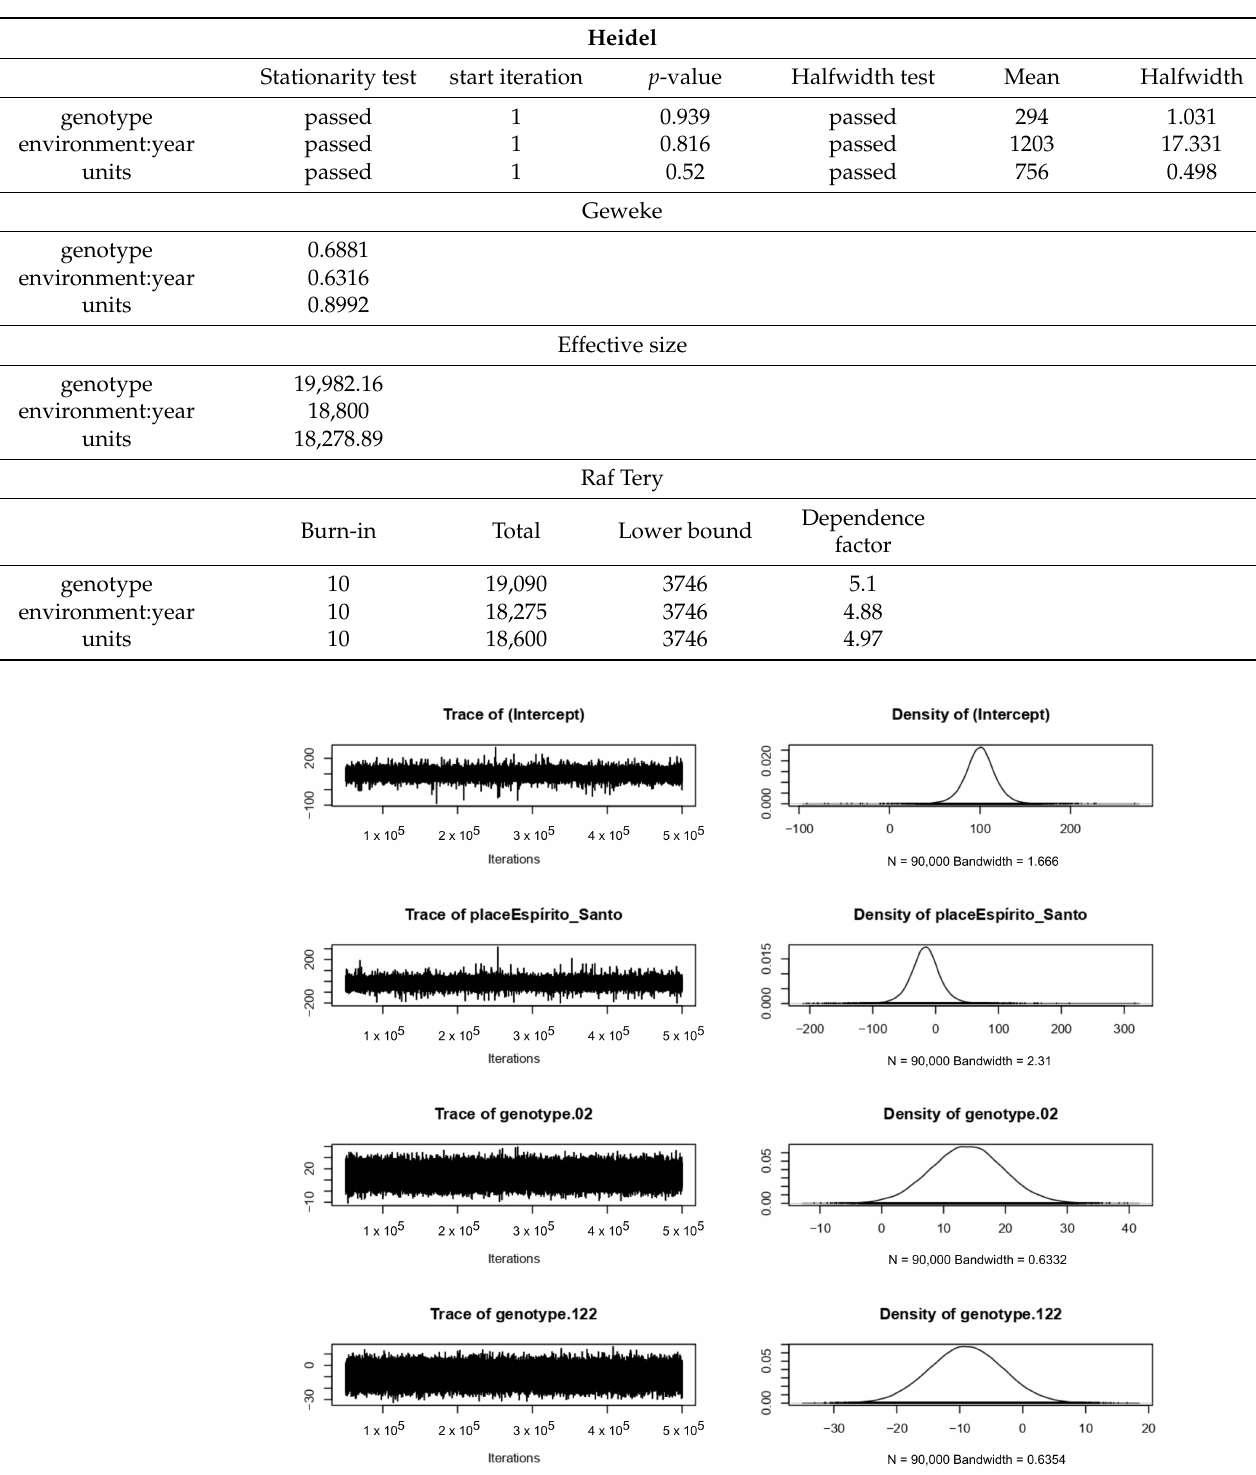
Table A1. Quality statistics of the Markov Chain convergence from 43 coffee ( Coffea canephora ) genotypes grown in Bahia and Esp í rito Santo.